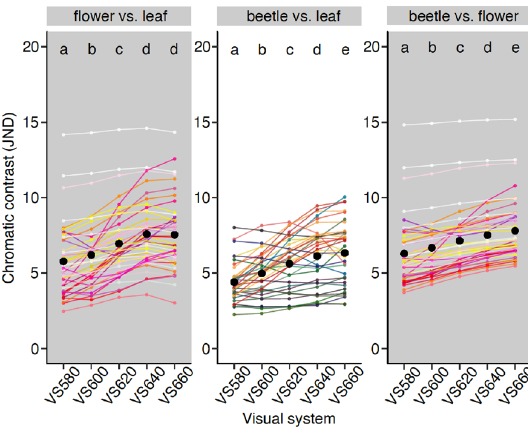
Figure 3. Comparison of chromatic contrast between visual systems (VS) with the long wavelength sensitive photoreceptor peaking at different wavelengths. Black dots show the means of the representative contrast values in each visual system. Each coloured dot represents the average contrast value of each flower pattern to all leaves (left panel), each beetle colour to all leaves (middle panel) or each flower colour to all beetle colours (right panel). Colours of the dots correspond to the human-visible colour of the flower (left and right panels) or beetle (middle panel) with the lines of the same colour connecting the results between different visual systems. This is for graphical representation only; statistical tests are based on all pairwise combinations of spectra and not averages. Letters on the top of each panel show the significant difference in contrast value between visual systems. Three contrast values > 10 JND are from flowers (2 white and 1 light pink) that have high UV—blue chroma compared to beetles and leaves. The Figure was created using R software version 3.6.3 (https:// www.r- proje ct. org) and modified using Inkscape version 1.0.2 (https:// inksc ape.